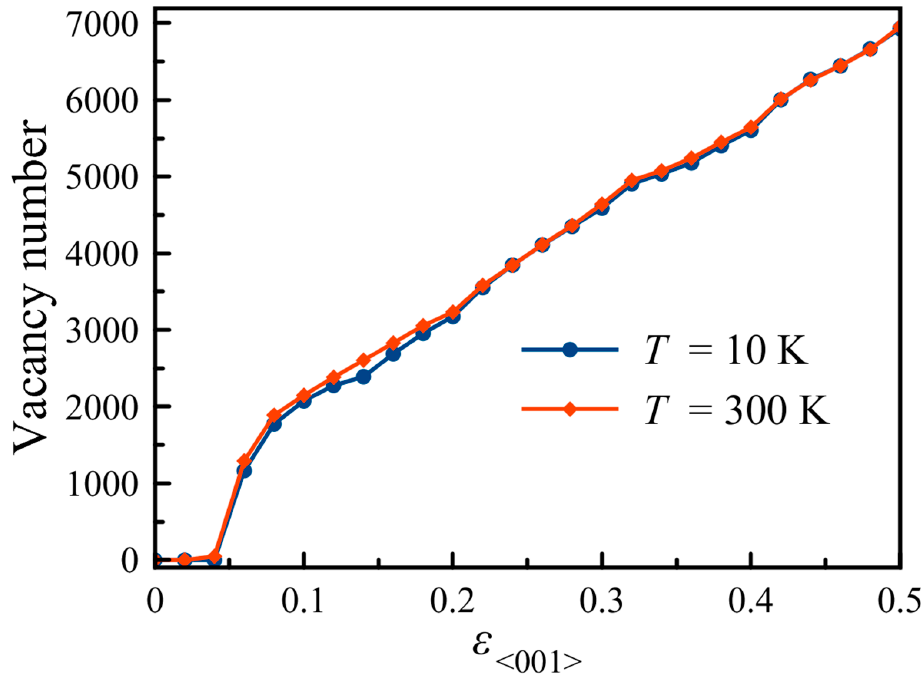
Figure 9. Vacancy number for uniaxial compressive loading of TiAl alloy in the <001> direction. The black and red circles represent the loading process at 10 and 300 K, respectively.